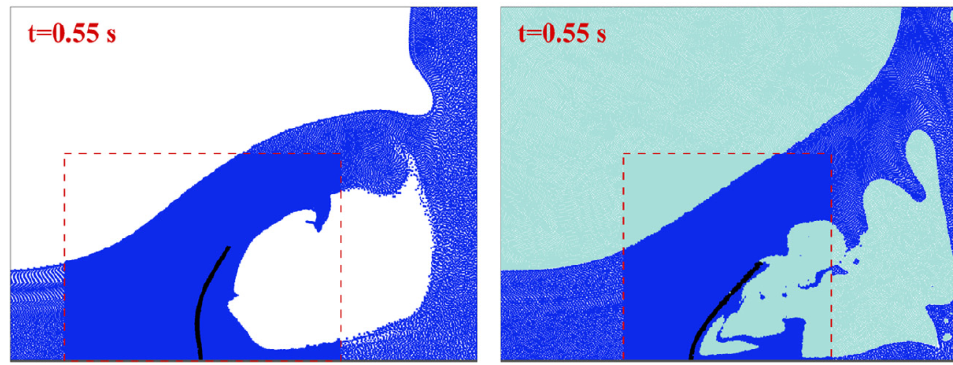
Figure 9. Simulations of a two-dimensional dam-break flow impacting an elastic plate (left: single- phase SPH simulation, right: multiphase SPH simulation) [9].